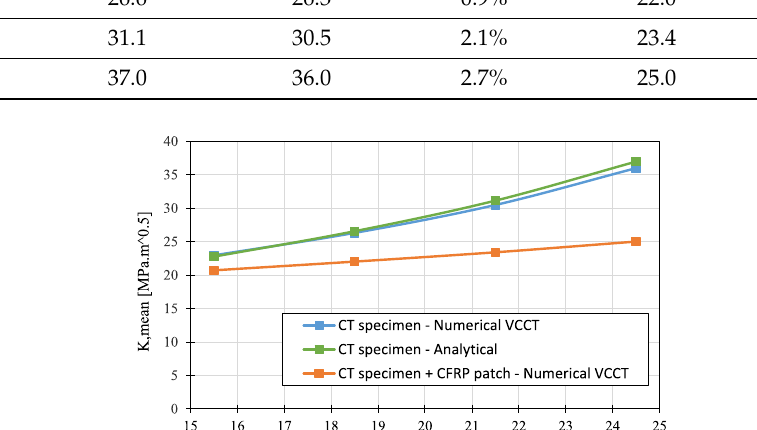
Figure 10. Numerical stress intensity factors for the strengthened and non-strengthened CT specimens, ( a ) variations of stress intensity factors (SIF) for crack length 15.5 mm, ( b ) variations of stress intensity factors (SIF) for crack length 18.5 mm, ( c ) variations of stress intensity factors (SIF) for